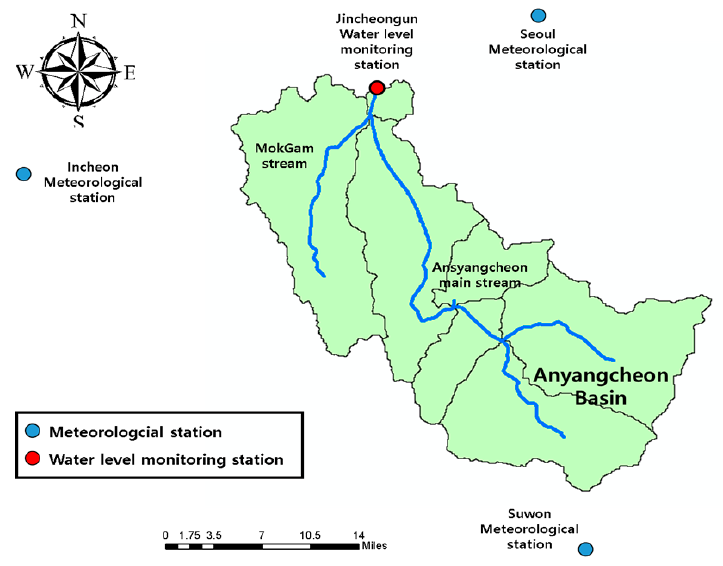
Figure 4. Anyangcheon basin and peripheral observation stations.